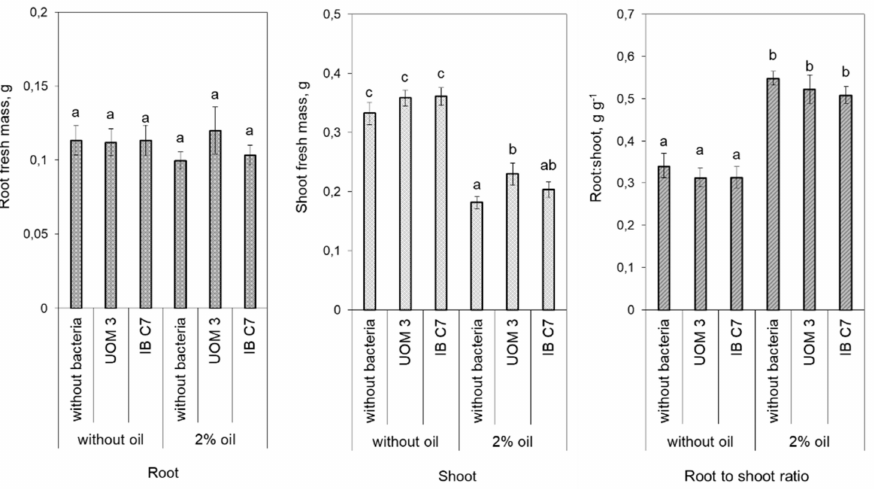
Figure 6. Root and shoot mass and root:shoot ratio in barley plants. UOM 3 and IB C7—treatments with introduction of Enterobacter sp. UOM 3 and P. hunanensis IB C7, respectively. Statistically different means for each characteristic (n = 18) are marked with different letters ( p ≤